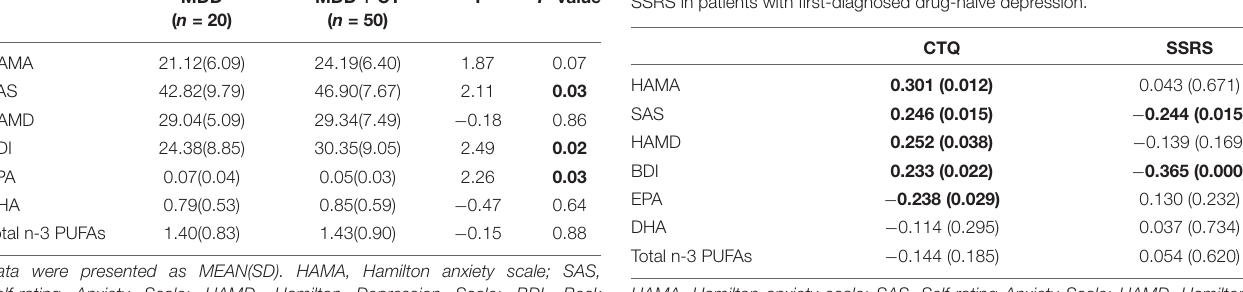
TABLE 5 | Correlations between symptomatic index and n-3 PUFAs levels, CTQ, SSRS in patients with first-diagnosed drug-naïve